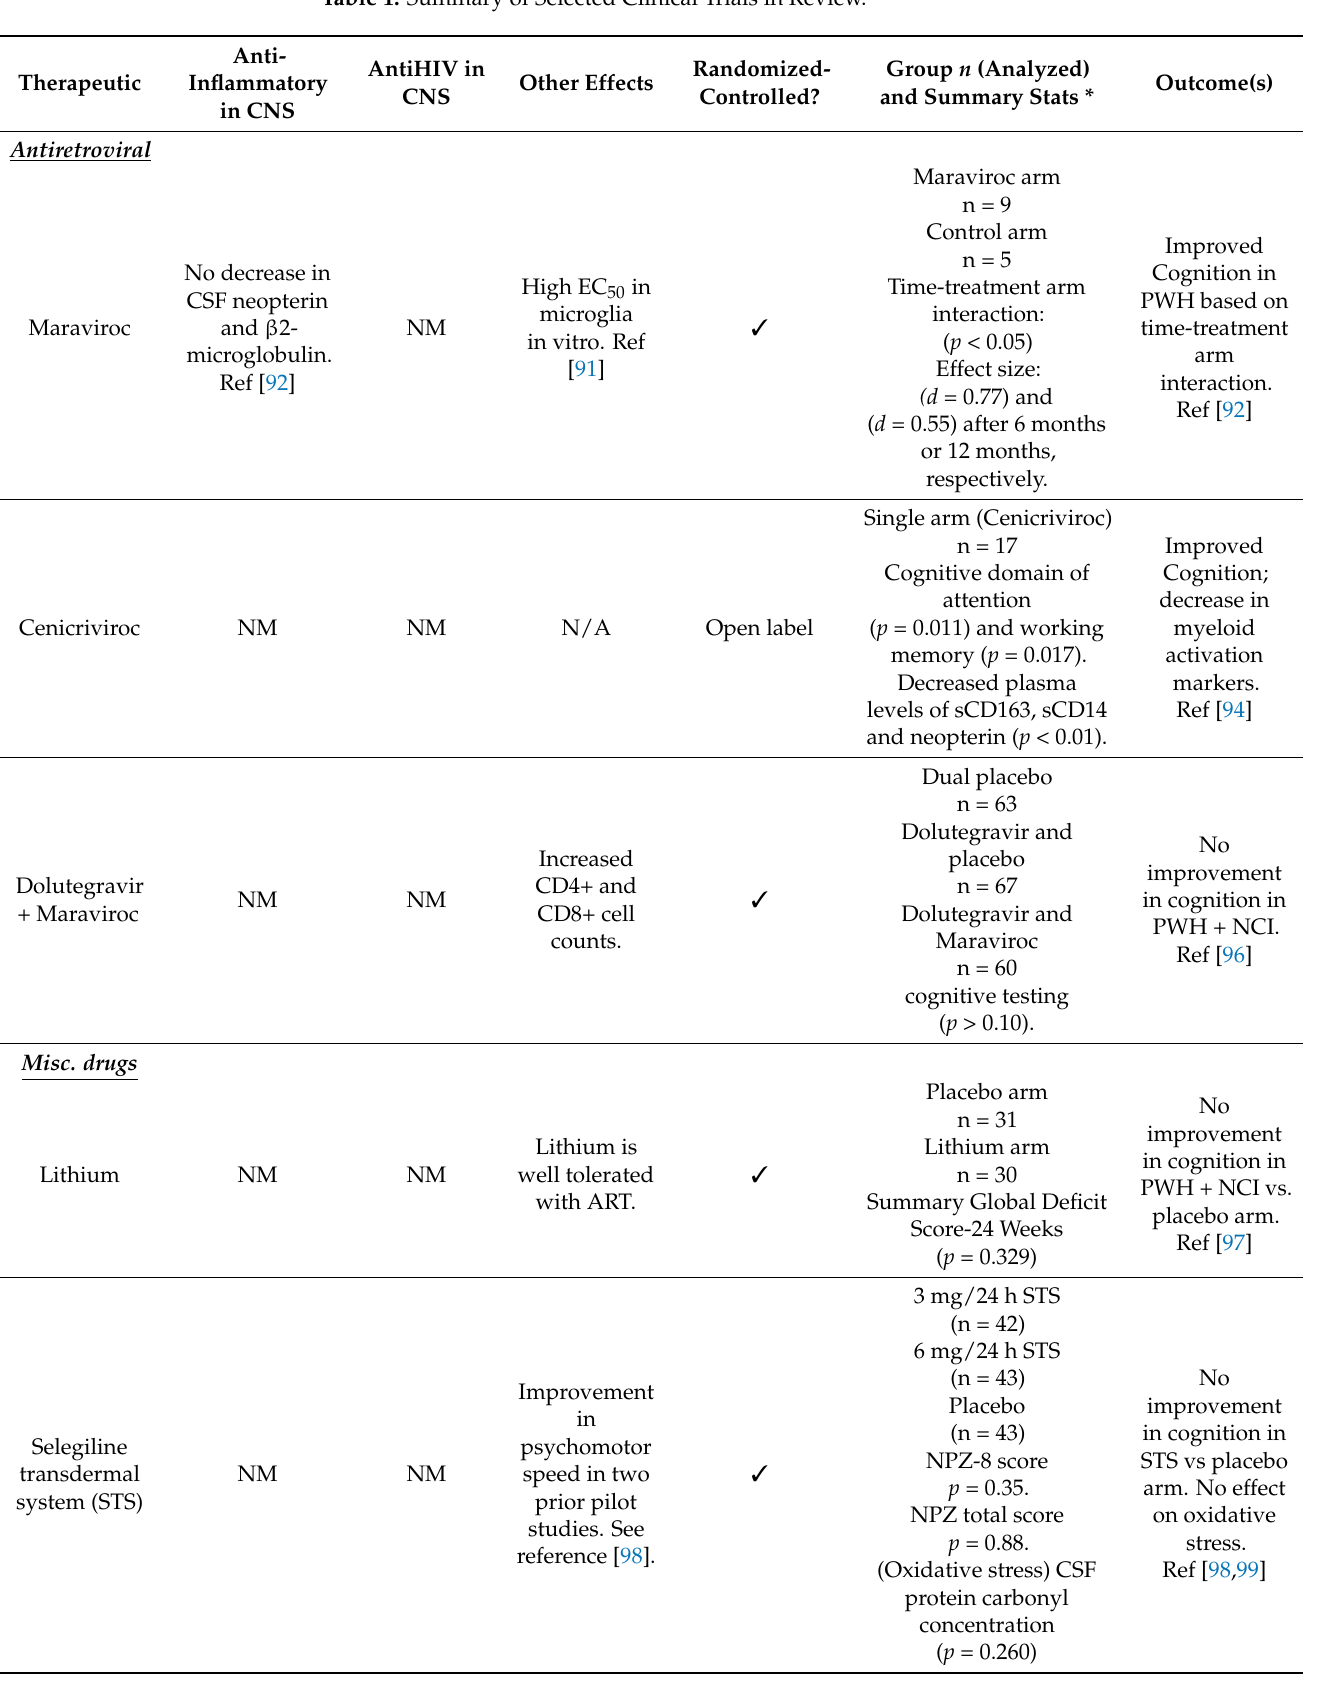
Table 1. Summary of Selected Clinical Trials in